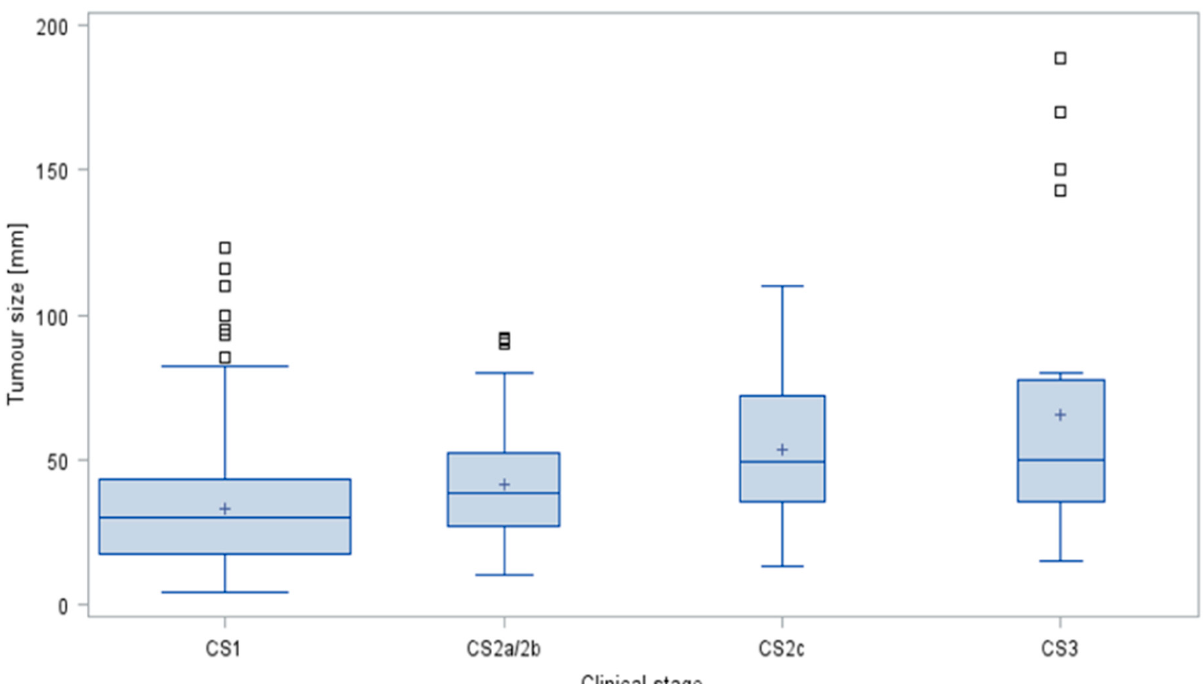
Figure 6. Tumour sizes in clinical stages in germ cell tumours. Box and whisker plots showing the distribution of tumour sizes stratified by clinical stages of testicular neoplasms. The boxes display the first quartile, median and third quartile. The whiskers are defined as the largest or lowest observed value that falls within 1.5 times the interquartile range measured from Q3 or Q1, respectively. Area of box denotes sample size. (cid:3) outliers; + denotes arithmetic mean; CS clinical stage.